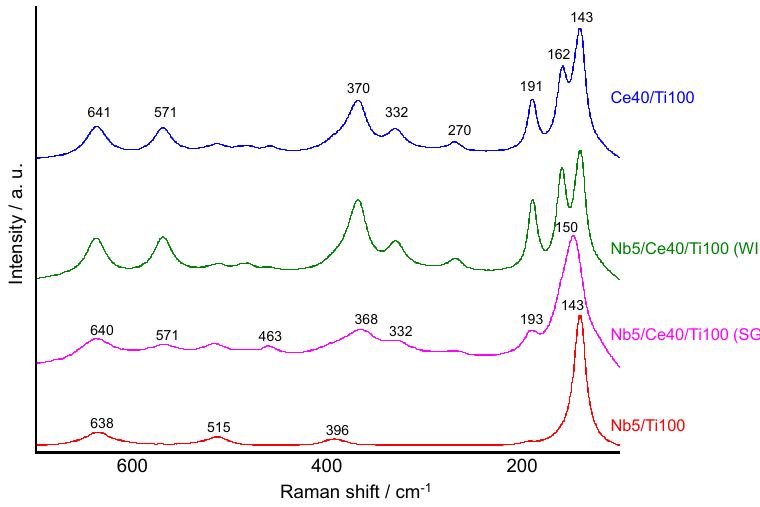
Figure 5. Raman spectra of all fresh samples.